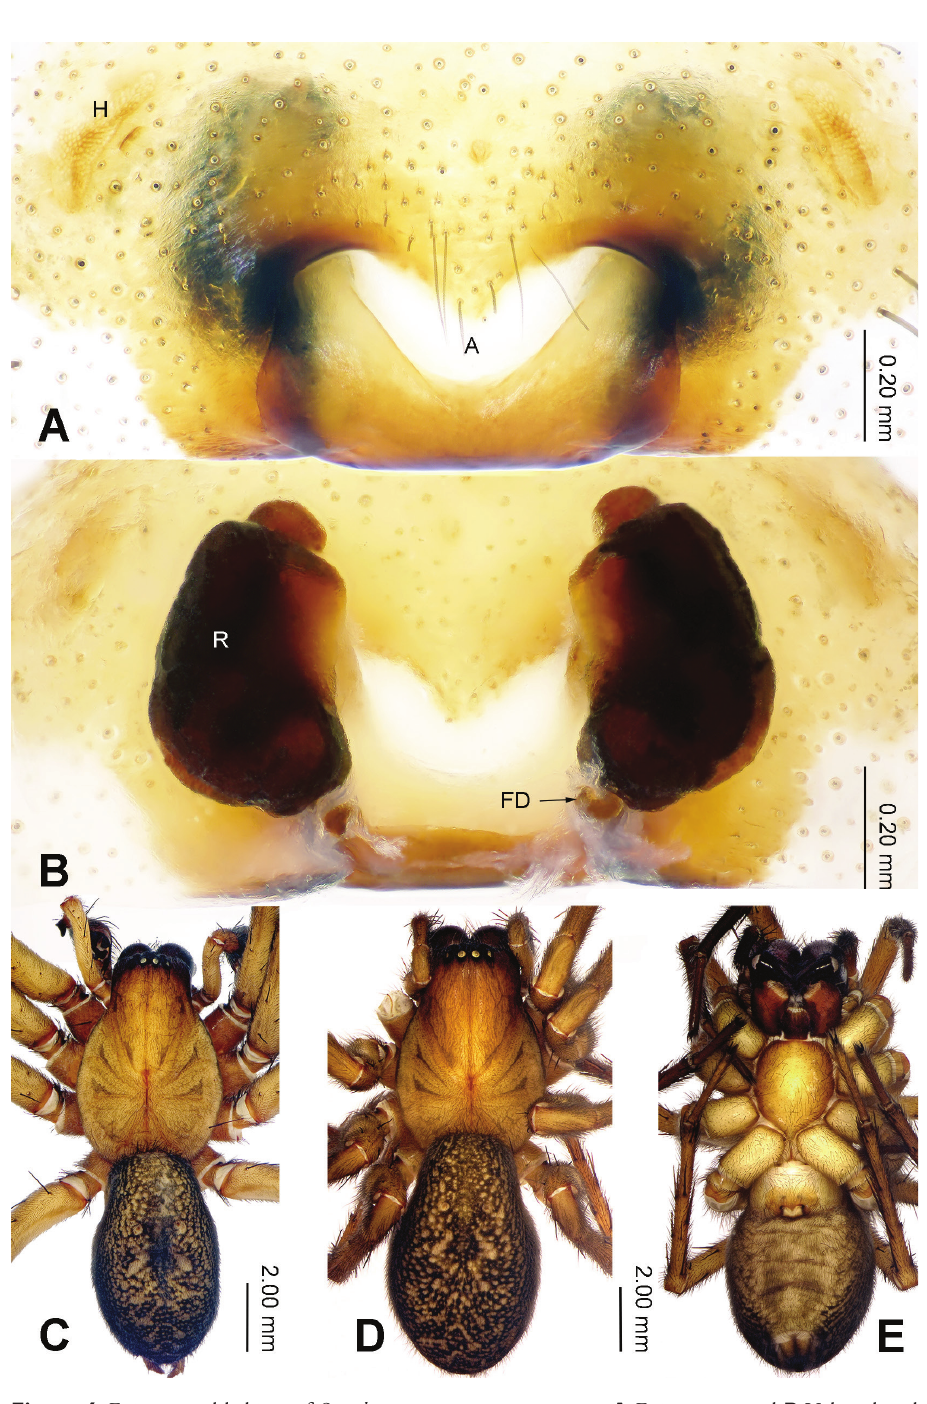
Figure 6. Epigyne and habitus of Sinodraconarius muruoensis sp. n. A Epigyne, ventral B Vulva, dorsal C Male habitus, dorsal D Female habitus, dorsal E Female habitus, ventral. Scale bar equal for D and E